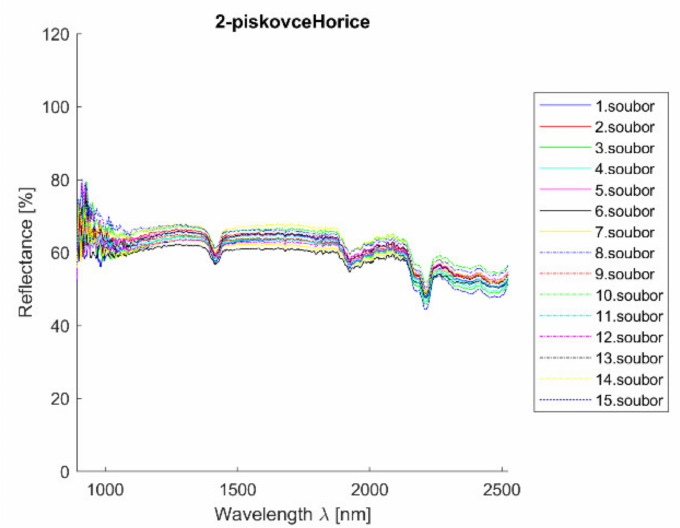
Figure 7. Hoˇrice sandstone—all measurements plot. Measurements were taken uniformly all over the sample to cover all possible sample